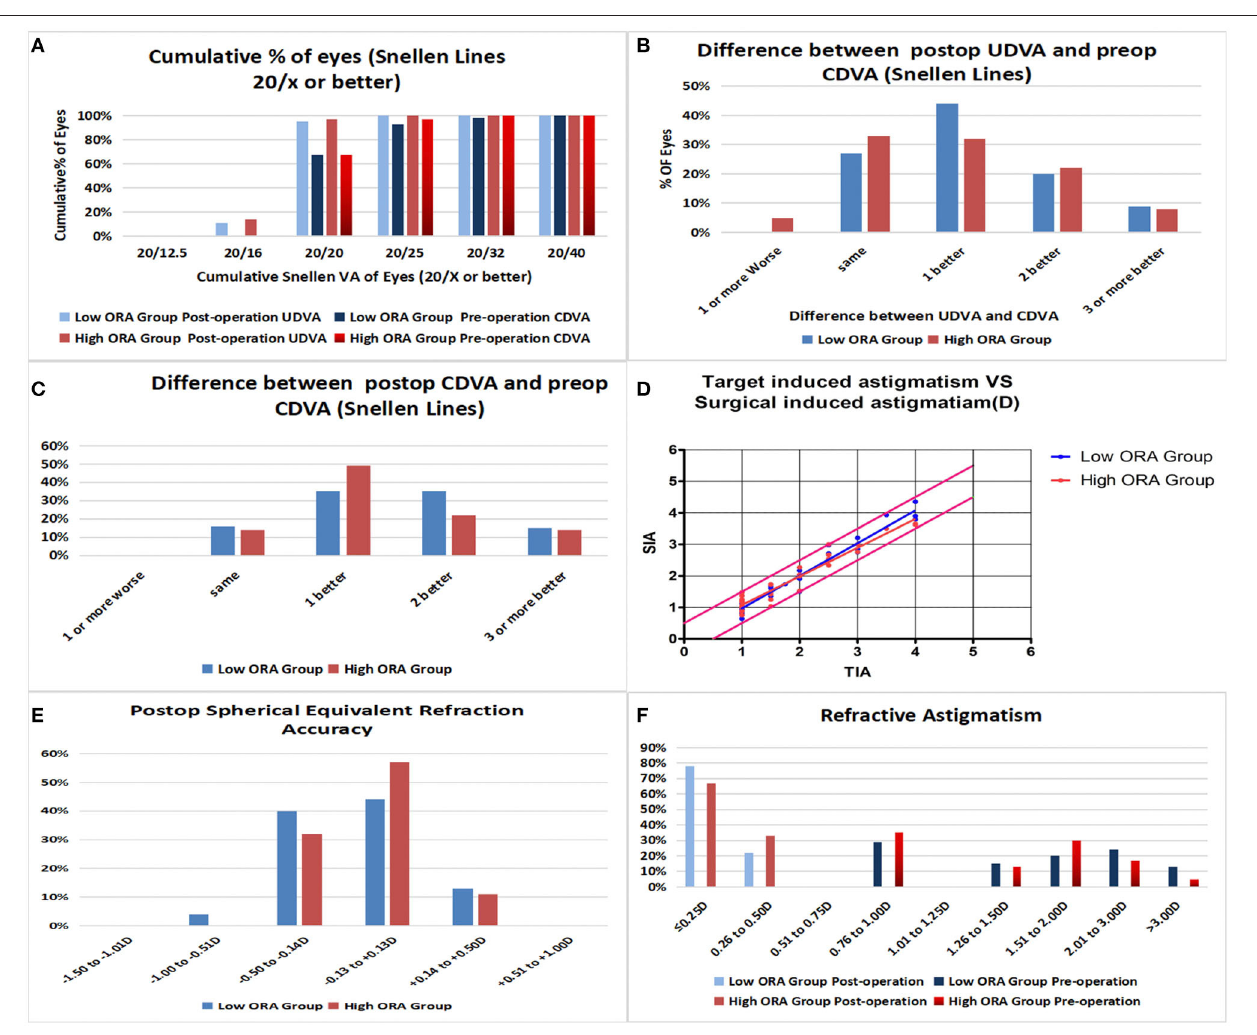
FIGURE 1 | Refractive outcomes in the low- and high- ocular residual astigmatism (ORA) groups. (A) Cumulative percentage of eyes attaining specified levels of uncorrected distance visual acuity (UDVA); (B) Postoperative vs. preoperative UDVA; (C) Change in corrected distance visual acuity (CDVA); (D) Target-induced astigmatism plotted vs. surgical-induced astigmatism at the last follow-up; (E) Distribution of postoperative spherical equivalent refraction; (F) Distribution of preoperative and postoperative astigmatism